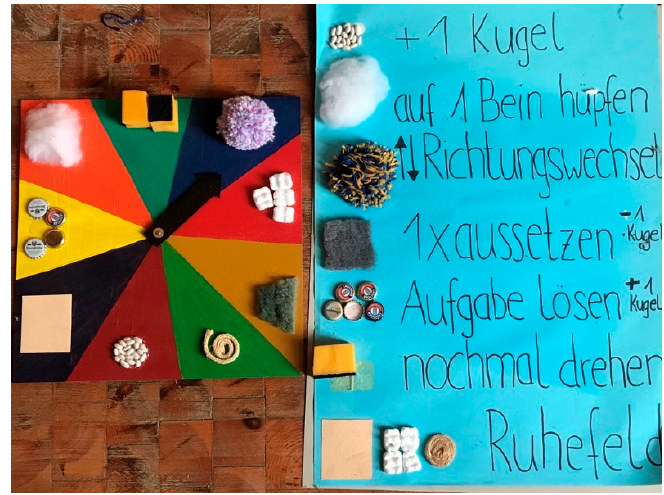
Figure 5. This is an example, from the Lippoldsberg Klinik, of older art therapies combined into a tactile game for patients, which helps them engage with social rules, sequences, color, texture, and shape.